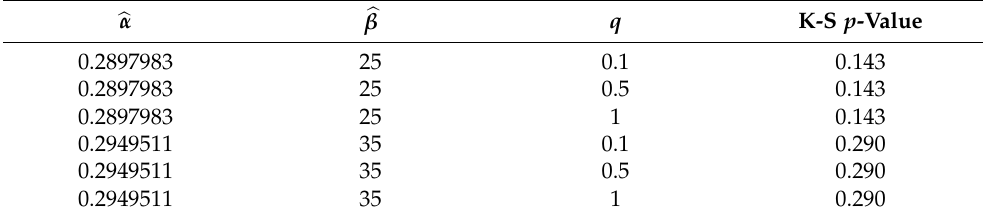
Table 1. The estimated parameters (cid:98) α , (cid:98) β for different values of q and the p -values based on one-sample Kolmogorov–Smirnov test.